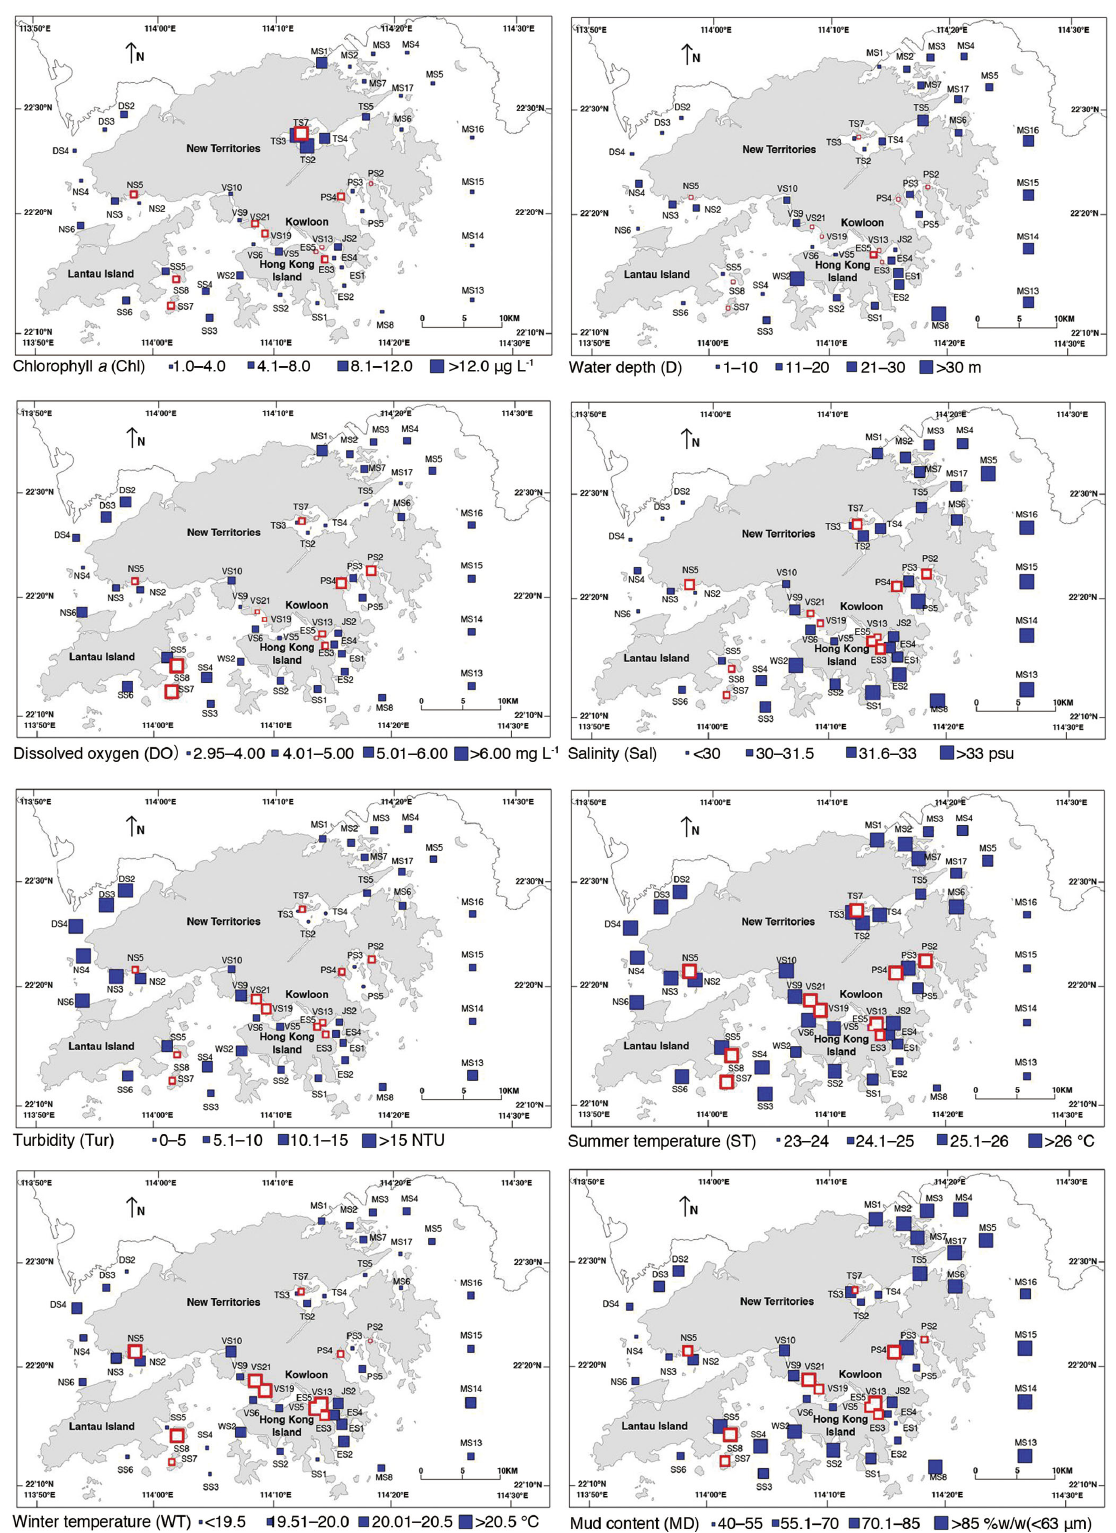
Figure 2. Spatial distribution of environmental parameters in Hong Kong. Mean surface water chlorophyll a concentration; water depth; summer (June to September) bottom-water dissolved oxygen content; mean bottom-water salinity; mean turbidity; mean summer (June to September) bottom-water temperature; mean winter (November to February) bottom-water temperature; and mean mud content. All are averaged values of the data obtained during 1986–2013 (Table